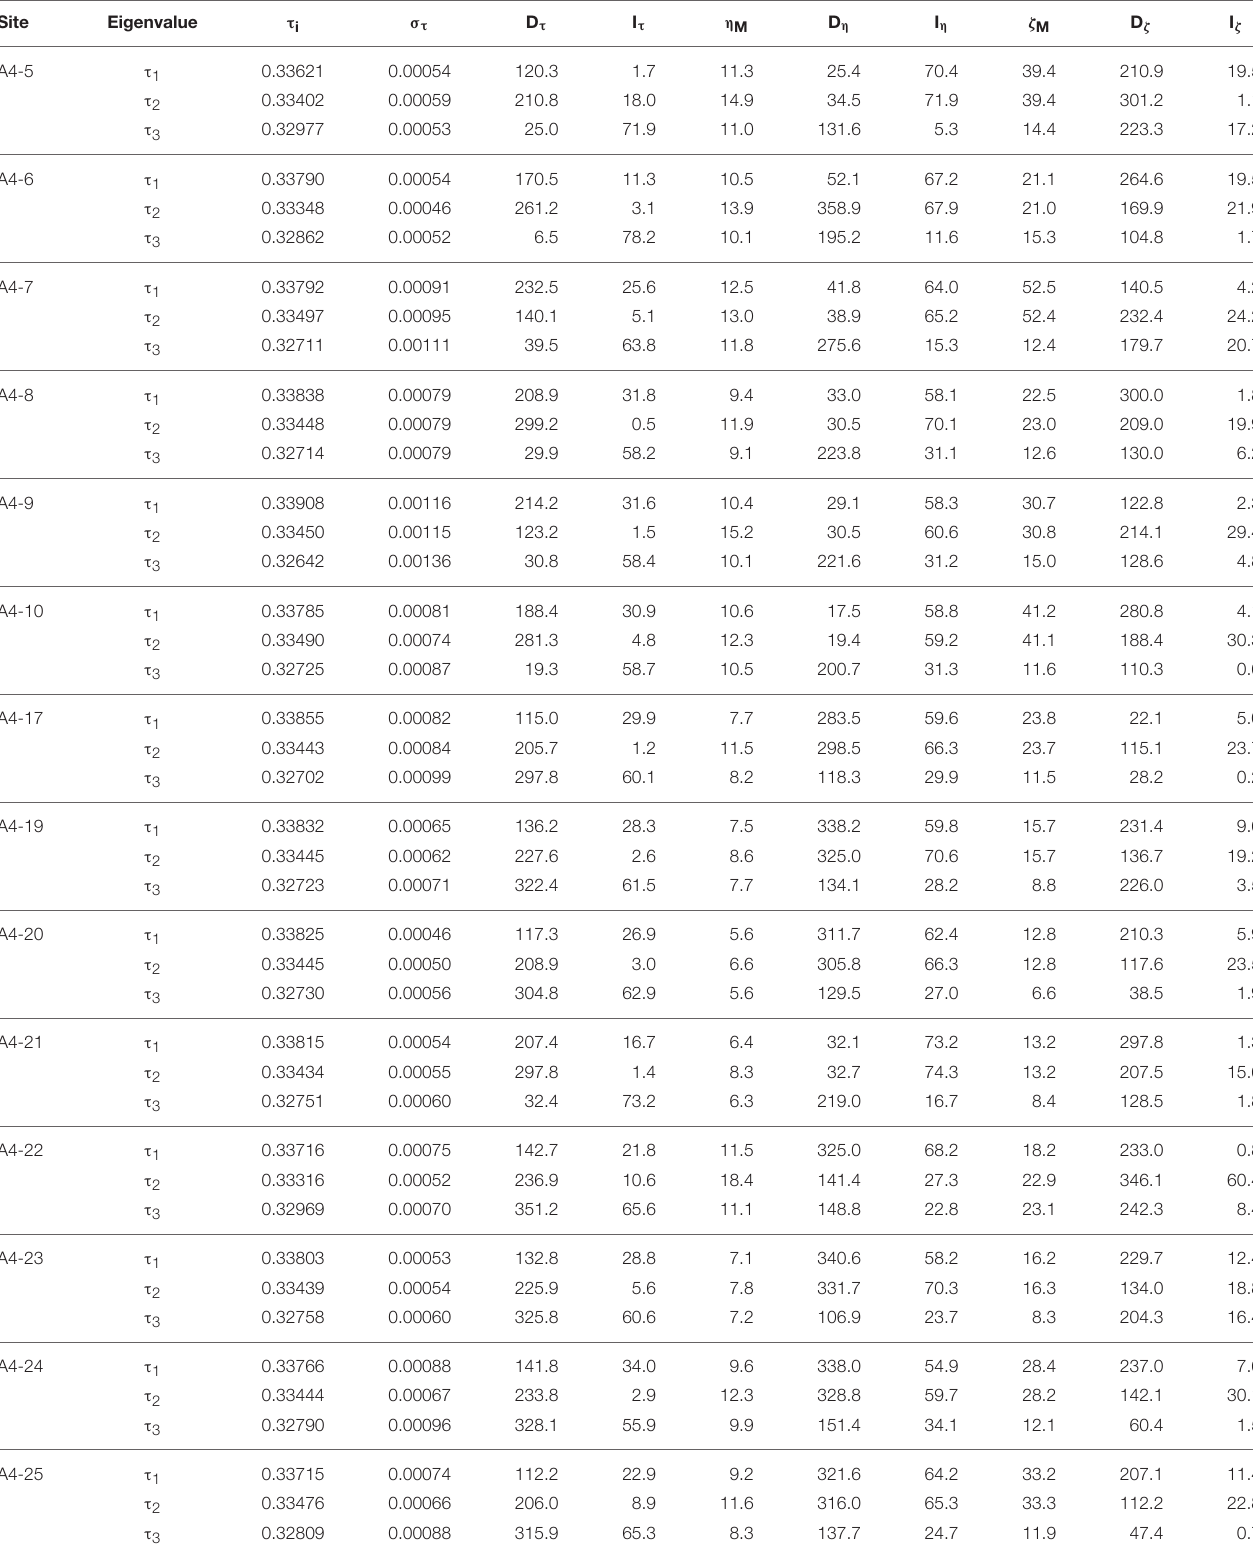
TABLE 2 | Site-mean AMS statistics of A4 member.